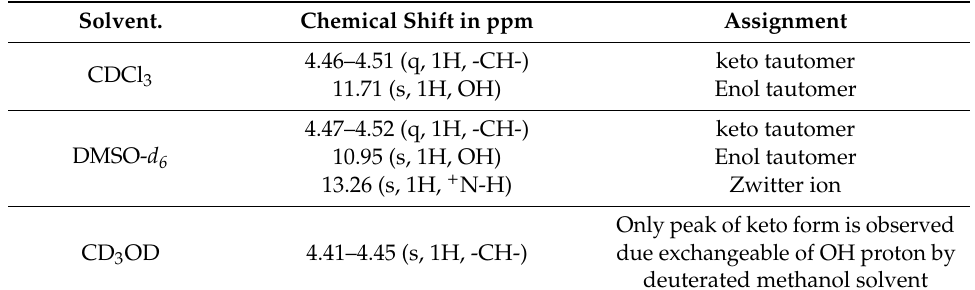
Table 1. Selected 1 H-NMR chemical shifts for Compound 3 in DMSO- d 6 , CDCl 3 and CD 3 OD